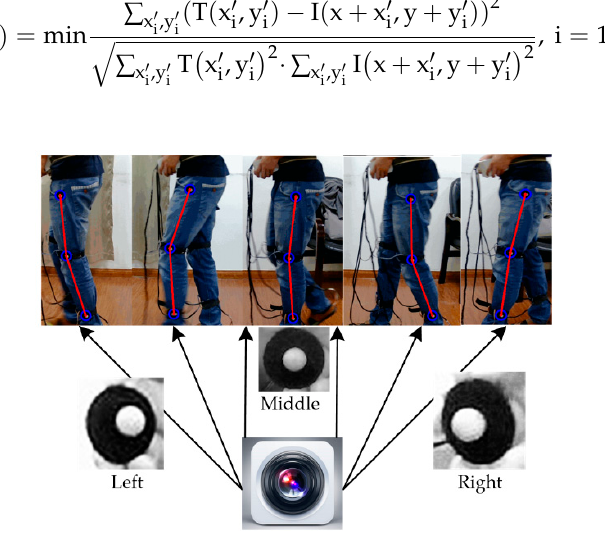
Figure 6. Different projection patterns for marker points.